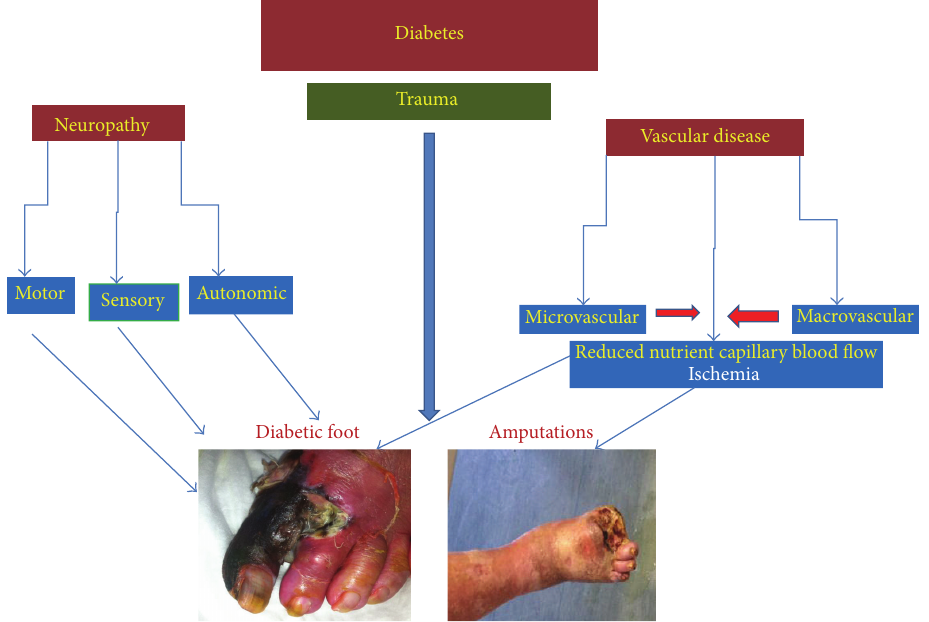
Figure 6: Pathogenetic pathway linking diabetes to diabetic foot